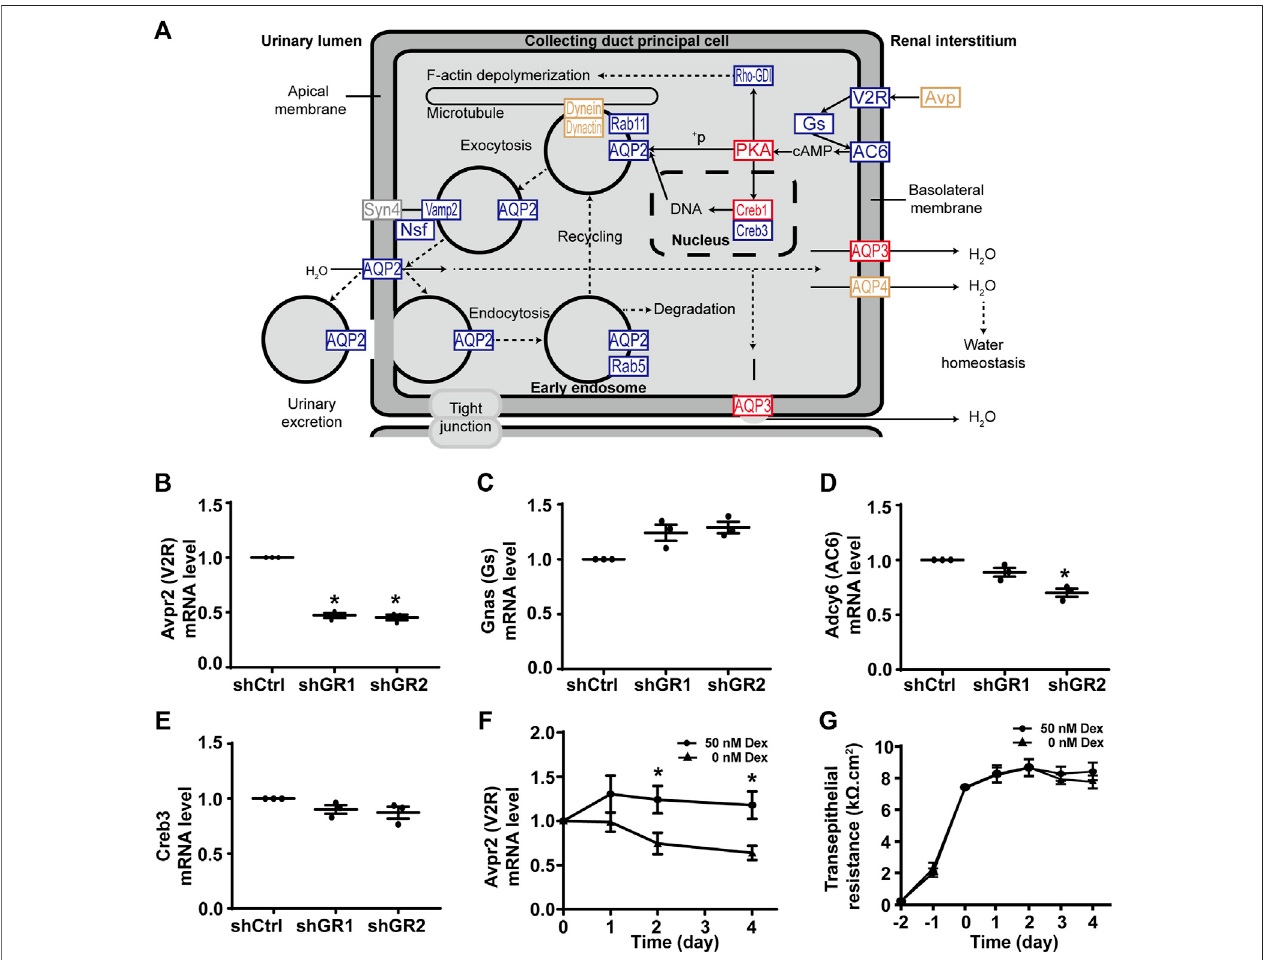
FIGURE 2 | Glucocorticoid receptor knockdown suppressed the KEGG “ vasopressin-regulated water reabsorption ” pathway in the mpkCCD cells. (A) KEGG “ vasopressin-regulated water reabsorption ” pathway. Genes are abbreviated and color-coded: blue, downregulated; gray: not found in the RNA-seq data; red, upregulated; yellow, no change in the glucocorticoid receptor knockdown cells. + P, phosphorylate. (B – E) Quantitative RT-PCR measurements of Avpr2, Gnas, Adcy6, and Creb3 mRNA in control (shCtrl) and glucocorticoid receptor knockdown (shGR1 and shGR2) cells under vehicle conditions. Values are mean ± S. E. summarized from three independent experiments. Asterisks indicate statistical signi fi cance ( p < 0.05, t -test). (F) Avpr2 mRNA level and (G) transepithelial electrical resistance of polarized mpkCCD cells exposed to 0 vs. 50 nM dexamethasone